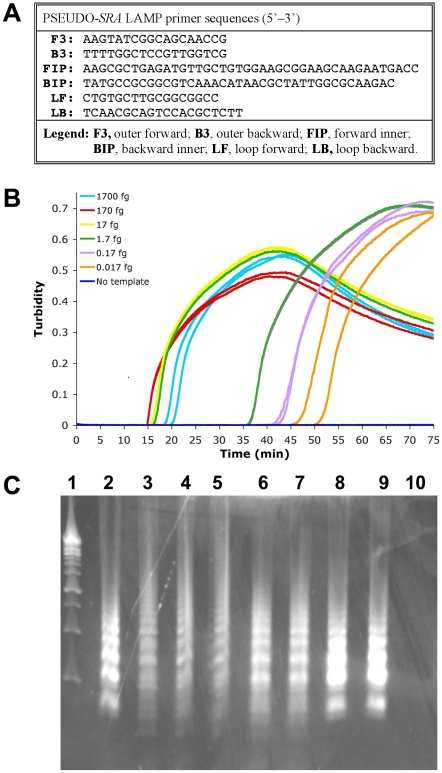
PSEUDO-SRA LAMP for the detection of T. b. rhodesiense genomic DNA.The PSEUDO-SRA LAMP primer set (Panel A) was tested with 1∶10 serially diluted T. b. rhodesiense IL1852 DNA (1700 fg to 0.017 fg) (Panel B). Replicates: Samples with DNA, n = 2; without DNA, n = 4. The data for each individual sample is presented as real-time turbidity values versus LAMP reaction time. As shown in Panel C, 5 µL reaction product after PSEUDO-SRA LAMP or SRA LAMP amplification of differing concentrations of T. b. rhodesiense IL1852 template were electrophoresed through 2% agarose gel containing ethidium bromide. From left to right: Lane 1, 1 kb DNA ladder (Fermentas); Lane 2, 17 pg IL 1852 DNA after SRA LAMP (Njiru [18]). Lane 3, 17 pg IL 1852 DNA after PSEUDO-SRA LAMP. Lanes 4–10, show a dilution series of template IL1852 DNA as follows: Lane 4, 1700 fg; Lane 5, 170 fg; Lane 6,17 fg; Lane 7, 1.7 fg; Lane 8, 0.17 fg; Lane 9, 0.017 fg; Lane 10, no DNA template.